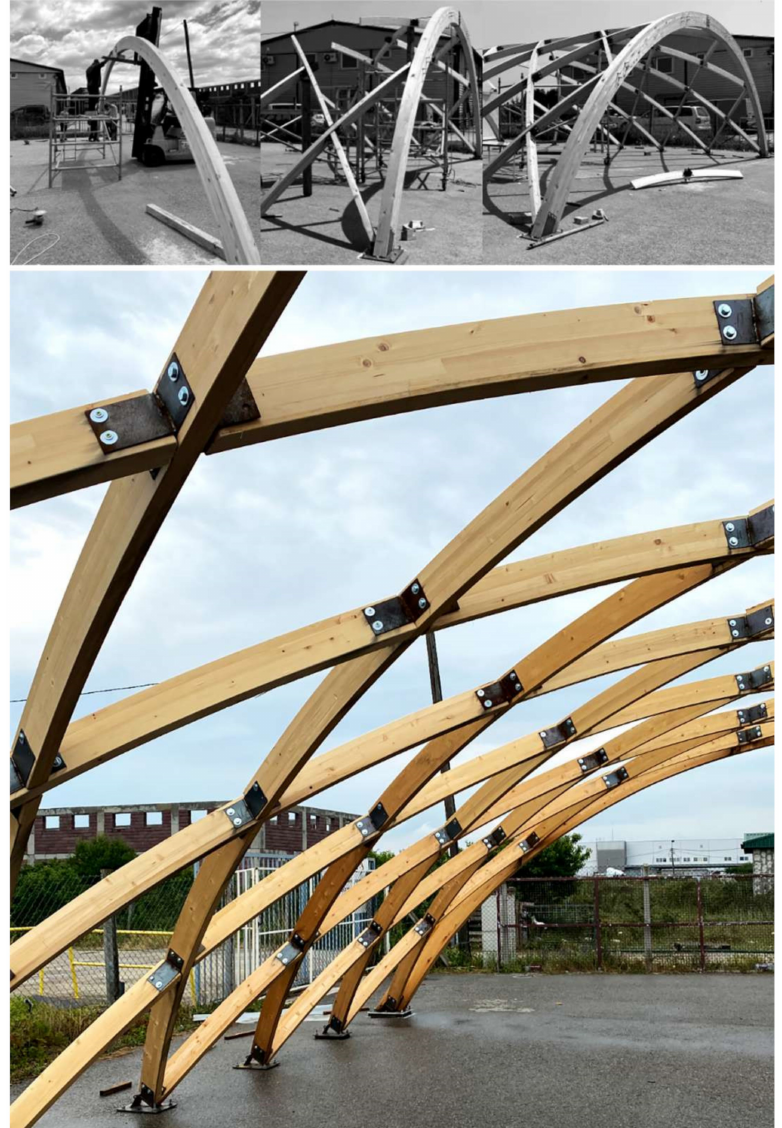
Figure 14. Photo of the construction process and the physical model in